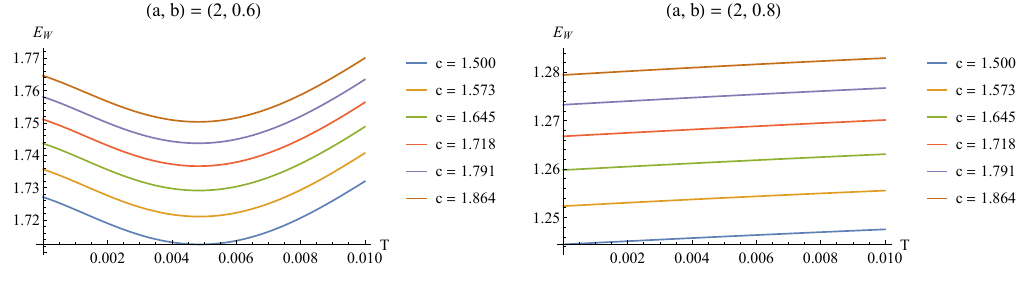
Figure 11 . EoP E W vs T at various ( a; b; c ). Di(cid:11)erent curves correspond to di(cid:11)erent c at ( a; b ) = (2 ; 0 : 6) (left plot) and ( a; b ) = (2 ; 0 : 8) (right